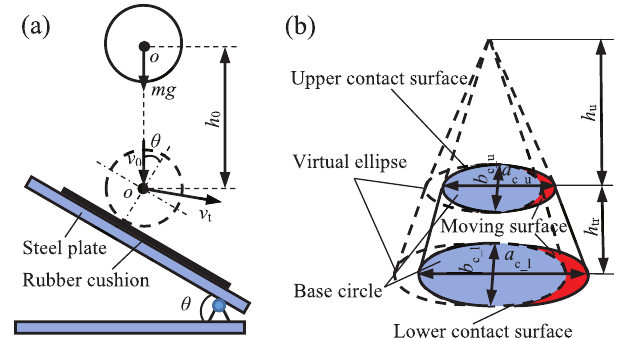
Fig. 1. (a) Oblique impact of sphere with rubber cushion and (b) its